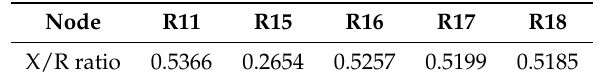
Table 1. X/R ratio of each Thévenin equivalent circuit of supply